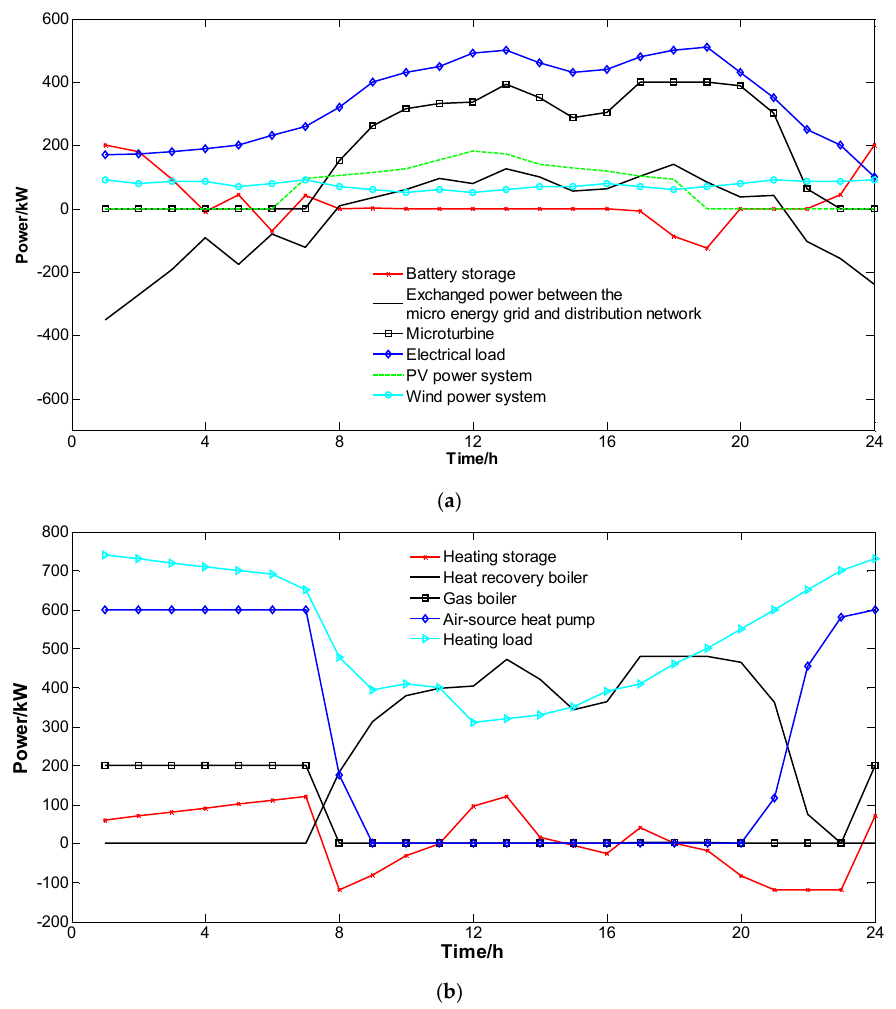
Figure 12. Electrical load ( a ) and heating load ( b ) dispatching schemes of the micro energy grid for a typical day in the winter when the distribution network comprising the micro energy grid was in the optimal dispatching state.